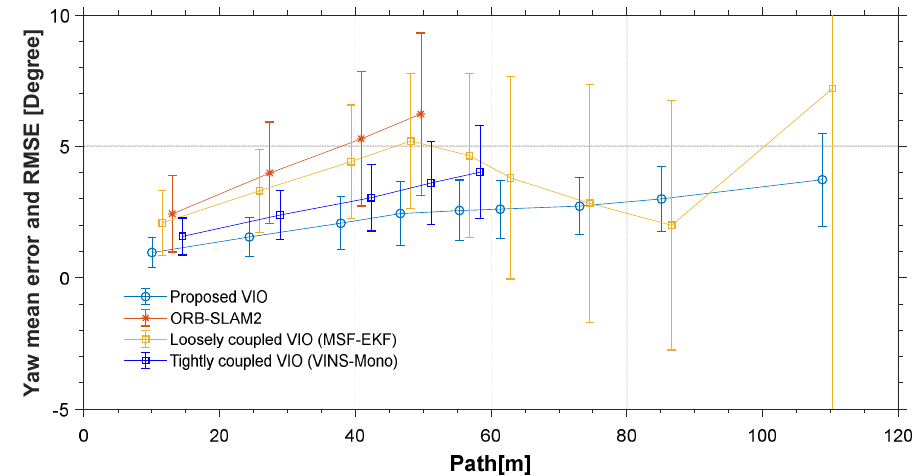
Figure 13. An illustration of value of yaw angle mean and RMSE from different methods. (VINS-Mono without output before initialization and value after system failing are ignored).